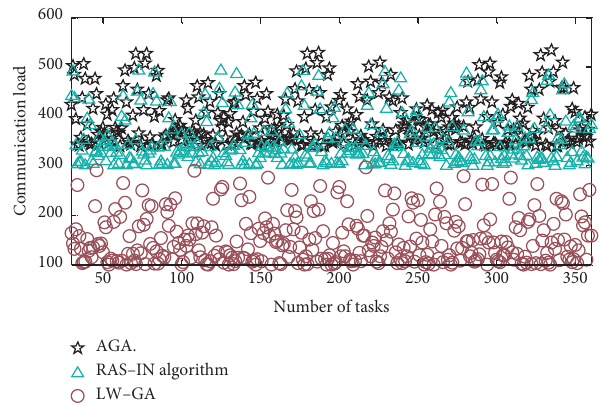
Figure 6: Comparison of the communication load of the three algorithms.